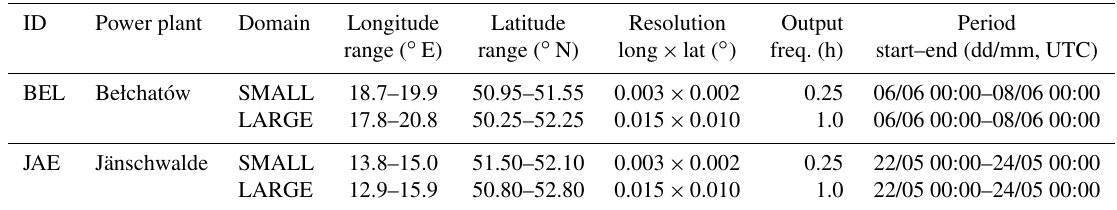
Table 4. Overview of the two model simulations, the minimum time period to be covered, and the longitude and latitude range and resolutions of the two output